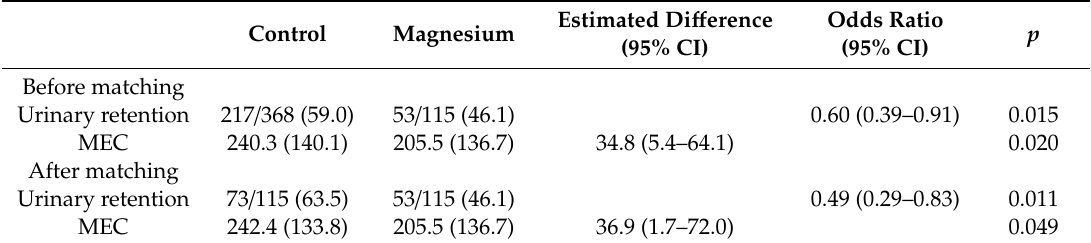
Table 2. Postoperative urinary retention and postoperative analgesia in POD 0 to 3, before and after propensity score matching.